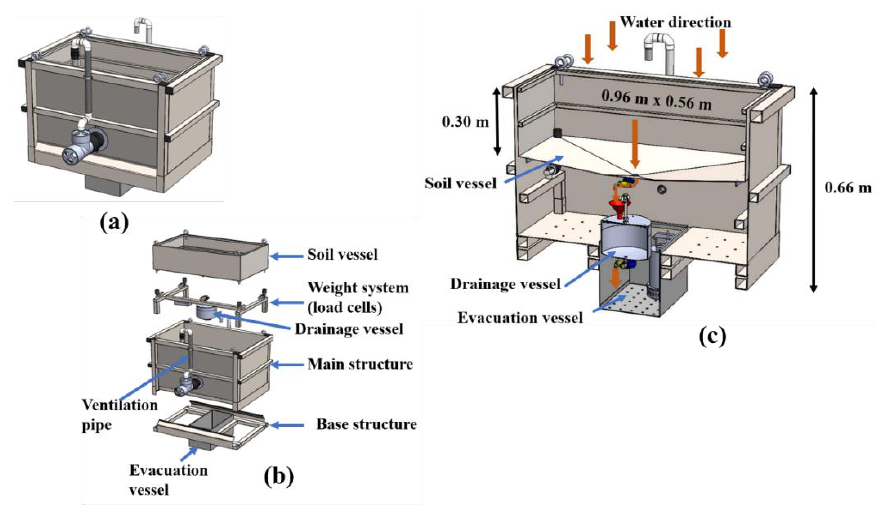
Figure 2. Compact weighing lysimeter ( a ) full view, ( b ) exploded view and ( c ) water movement through the vessels.